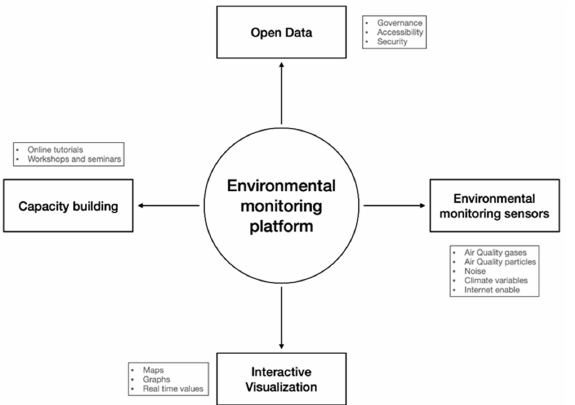
Figure 1. Multi-dimensional framework for an environmental monitoring platform.